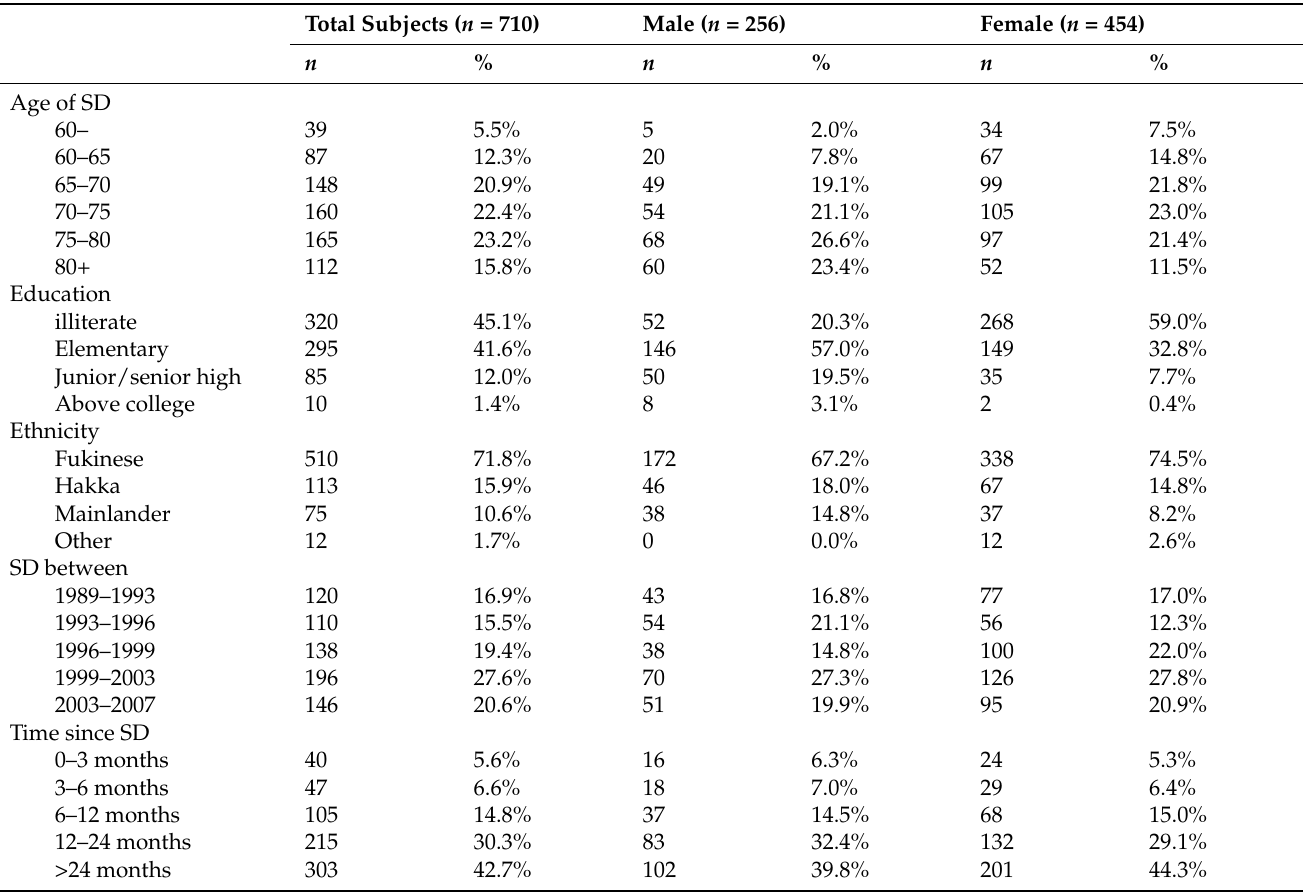
Table 3. Characteristics of study